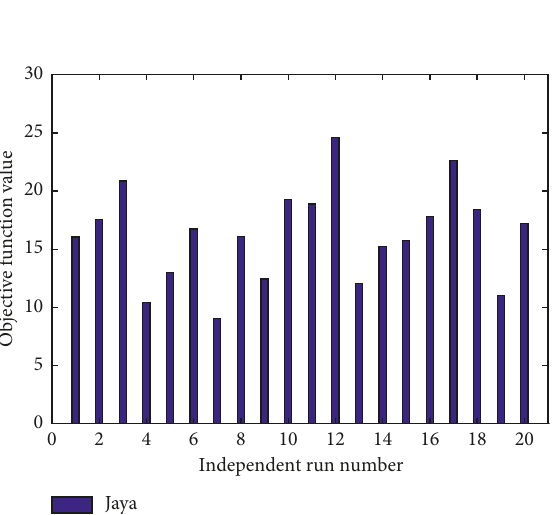
Figure 11: Convergence characteristics for the 8-bus system by MINLP formulation.